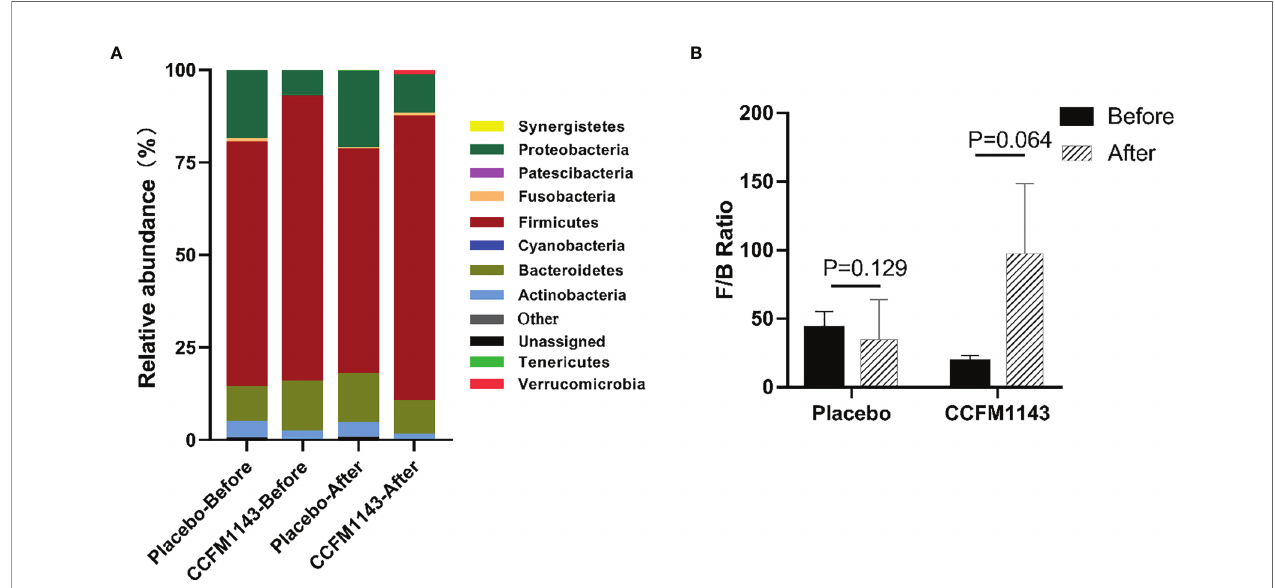
FIGURE 5 | Effect of Lactobacillus plantarum CCFM1143 on the phylum level of the gut microbiota in patients with diarrhea. (A) Microbial distribution at the phylum level. (B) The Firmicutes and Bacteroidetes (F/B)